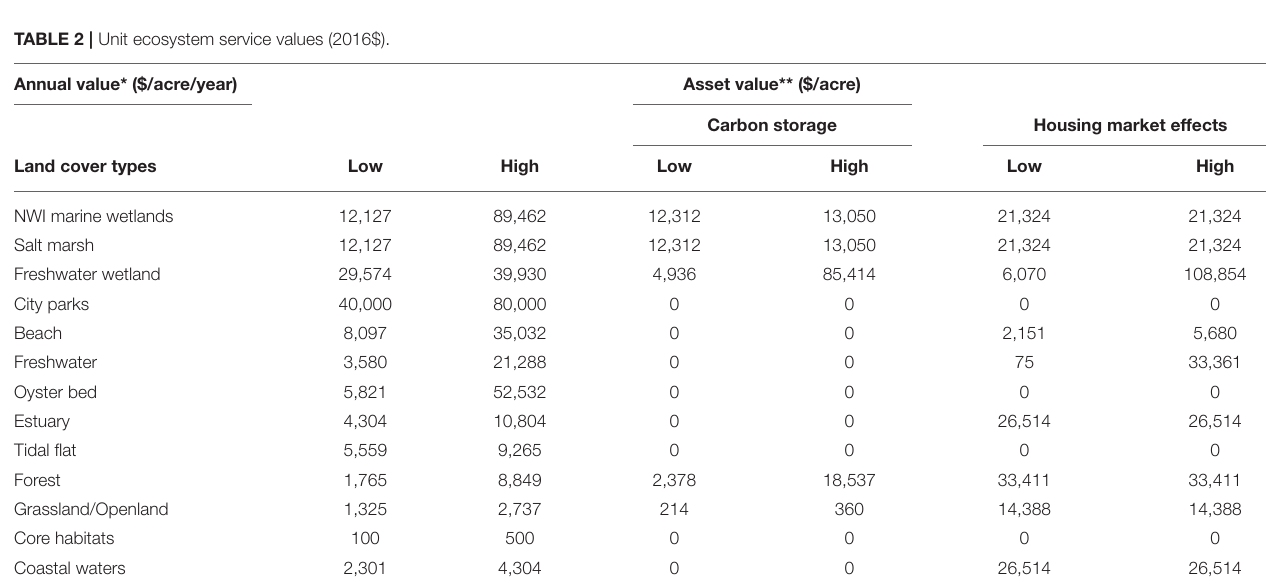
* Data Sources in Table A1 in Appendix. ** Data Source: Kocian et al. (2015).